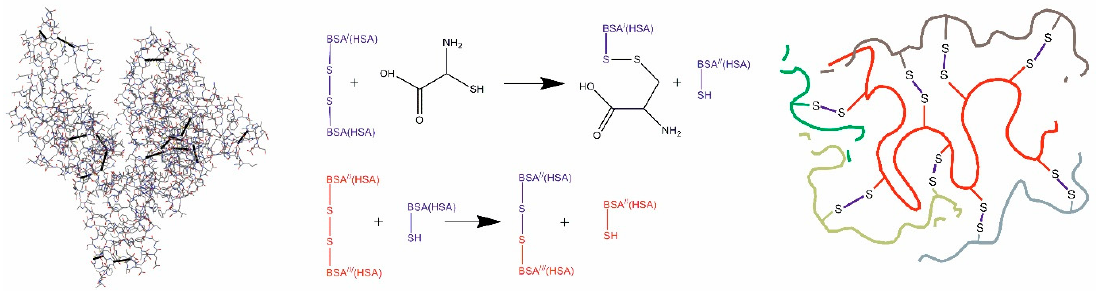
Figure 2. Cysteine interaction with BSA(HSA) (the left part is structural arrangement of double sulfide bonds in albumin, the right part is a schematic representation of bounded particles).